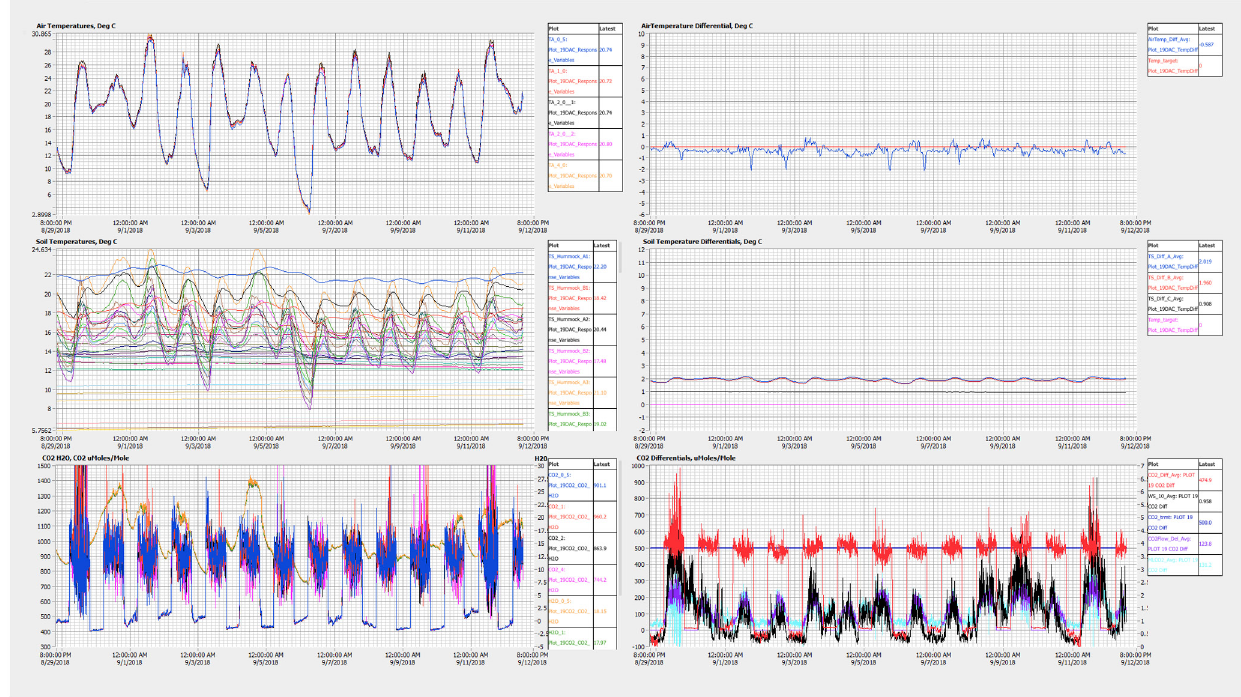
Figure 5. Monitoring processes at plot 19 via VDV software at